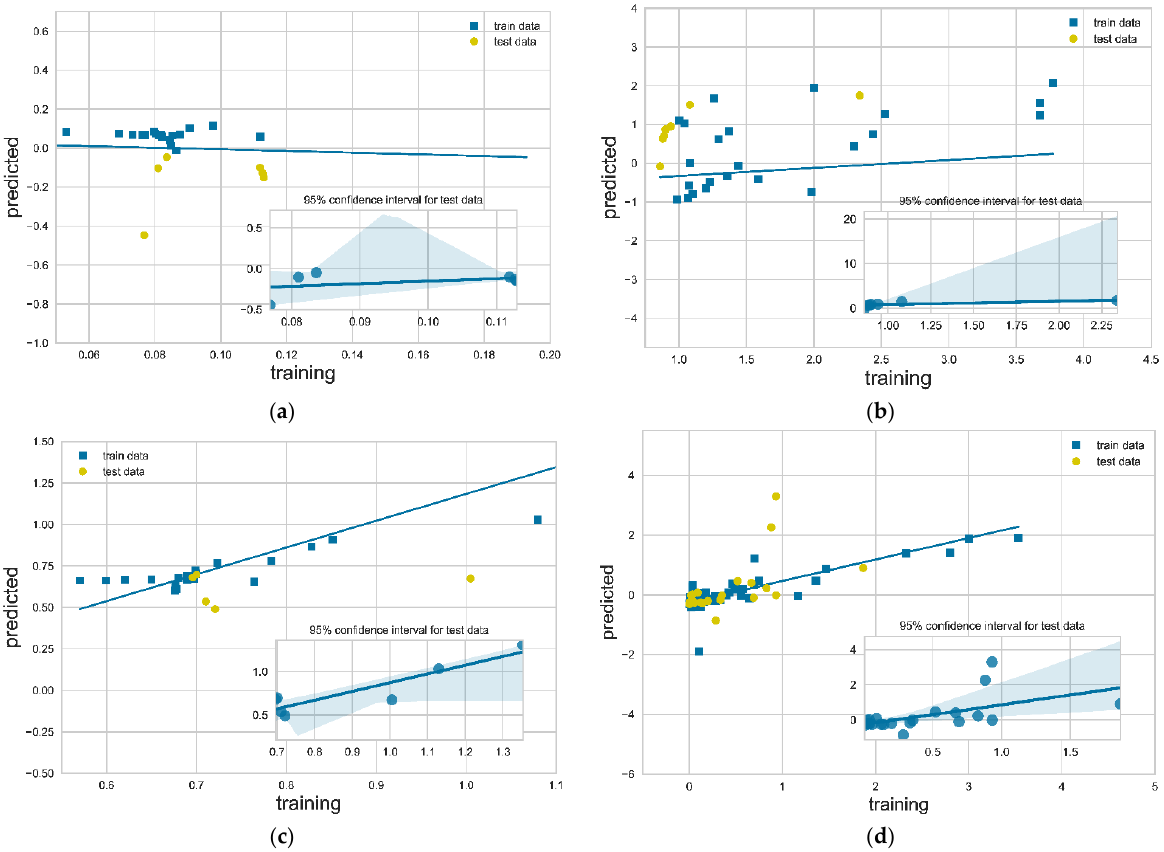
Figure 5. Error estimation for dataset parameters: ( a ) D , ( b ) η , ( c ) k and ( d ) u m . Lines are the respective regression lines from the ML models in Figure 2. Insets display the 95% confidence intervals for the predicted values of each output. However, further investigation is needed to characterize a data point as outlier or not. Towards this direction, we have employed two of the most widely used statistical tools, the residuals plot and the Cook’s Distance plot. Visualization for these is made possible with the Python Yellowbrick package [46]. The residuals plot presents the cal- culated difference between the real value and the predicted value, i.e., the prediction er- ror. Figure 6a is a residual plot for D train and test data. Data points are scattered around the horizontal axis. A good regression fit is considered when data are close to the hori- zontal line. The respective histogram shows that the induced error is distributed around zero. There are data points in the histogram far from zero, nevertheless, the main distri- bution is around zero. Train and test R 2 values shown in the diagram are similar to the average value shown in Table 4. To strengthen our statistical evidence, Figure 6b depicts the calculated Cook’s dis- tance for the diffusion coefficient in our model (Equation (9)), a measure that identifies the influential outliers, providing the index of the data from a stem plot, where a hori- zontal line is drawn at the 4/ n threshold. Stems above this line are possible outliers and their percentage is shown in the Figure legend. For the diffusion coefficient, D , simula- tion data with index = 24 are considered as outliers. Going back on the dataset incorpo- rated, it is found that this point belongs to a simulation result from a h = 18.5 σ na- nochannel, taken from our in-house simulations, with the extreme value of wall/fluid